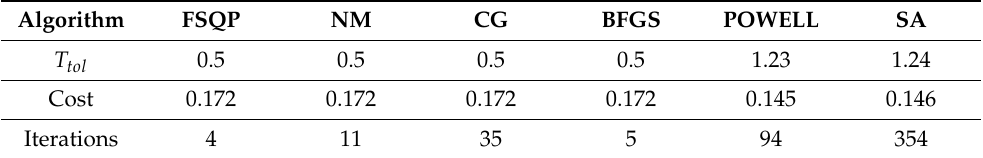
Table 1. Comparison of different optimization